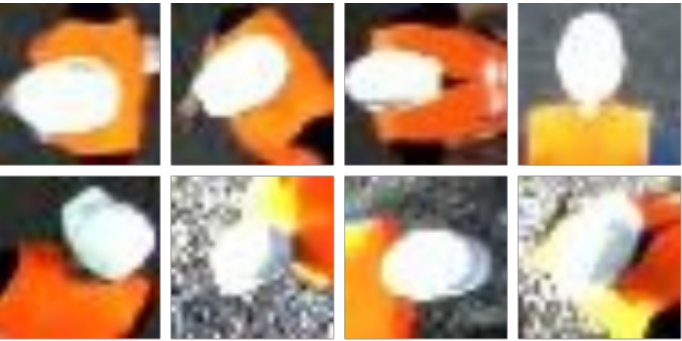
Figure 2. The training dataset contains construction workers taken from the top view. The workers are in different orientations and illuminated in different